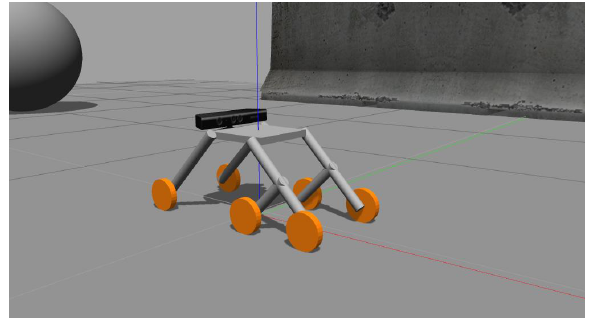
Figure 4. Gazebo simulation of